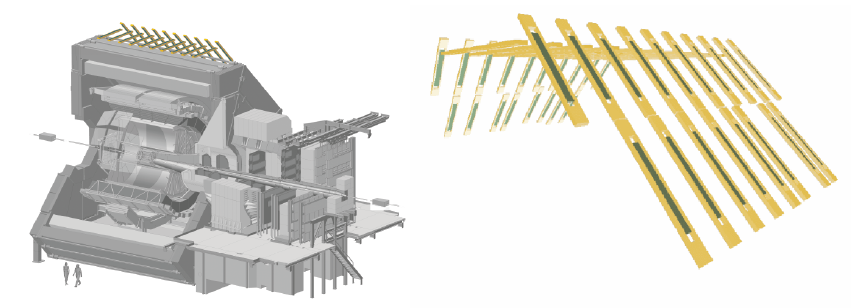
Figure 5. On the left: ALICE with the ACORDE detector on the top (yellow). On the right: the ACORDE cosmic ray detector